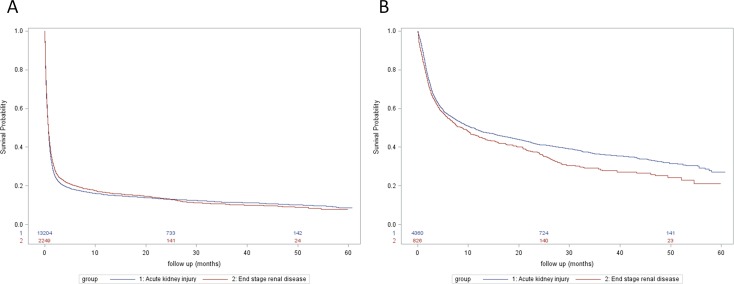
Kaplan–Meier survival curves for long-term survival.(A) Total population (HR 0.98, 95% CI 0.93–1.03; adjusted HR 1.02, 95% CI 0.97–1.07) (B) Patients who survived and discharged from index hospitalization (HR 1.16, 95% CI 1.05–1.28; adjusted HR 1.21, 95% CI 1.09–1.34).